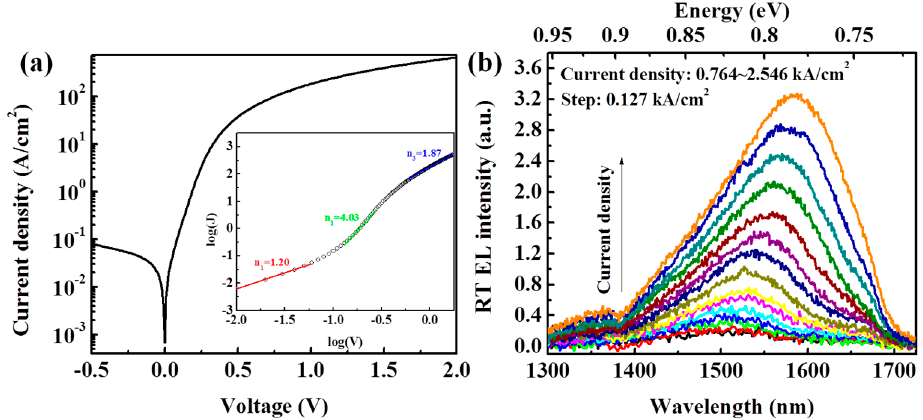
Figure 3. ( a ) Typical J – V characteristic of the diode; and ( b ) corresponding EL spectra under injection current densities of 0.764–2.546 kA/cm 2 with a step increase of 0.127 kA/cm 2 at room temperature.